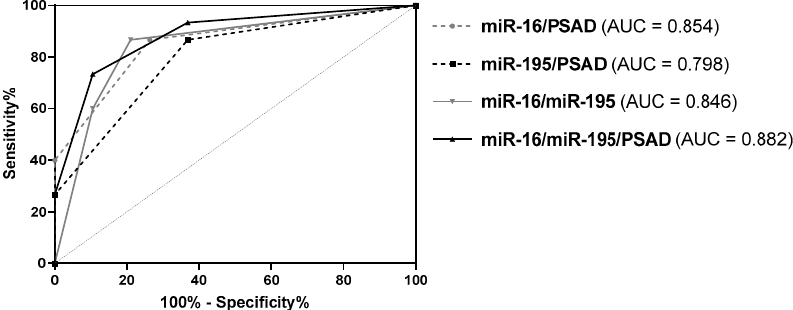
Figure 5. ROC curve analysis of the combinations miR-16/PSAD, miR-195/PSAD, miR-16/miR-195, and miR-16/miR-195/PSAD using the sub-cohort of patients with PSA levels ≤ 10 ng/mL ( n =